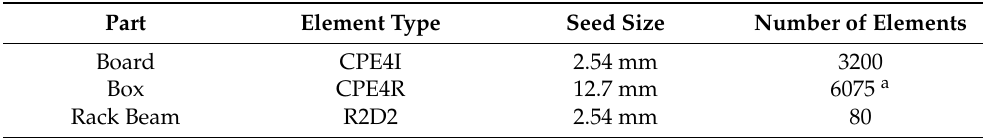
Table 6. Mesh properties for each object in the